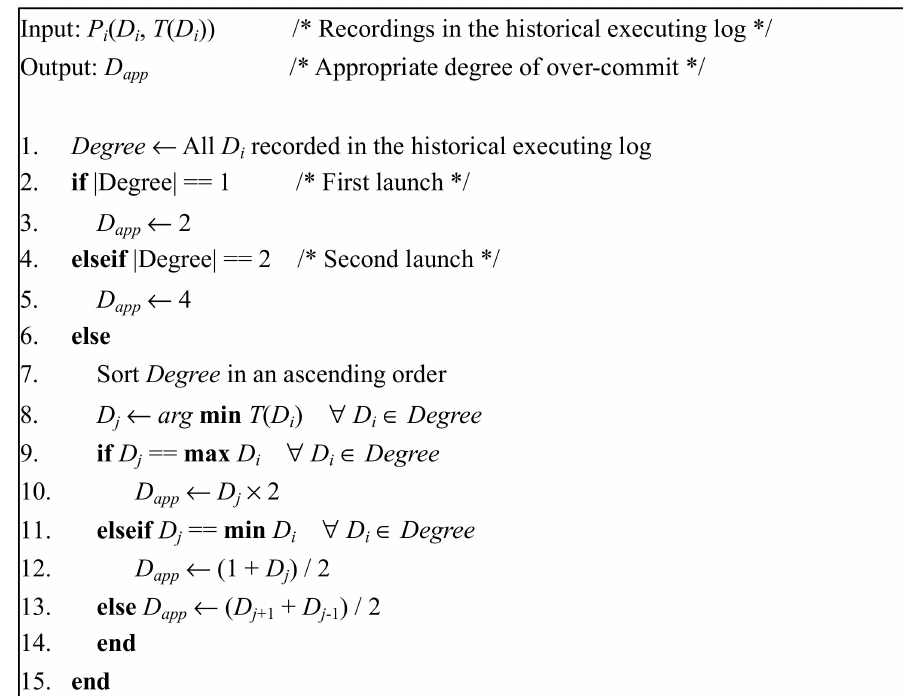
Figure 4. Pseudo-code of resource estimating